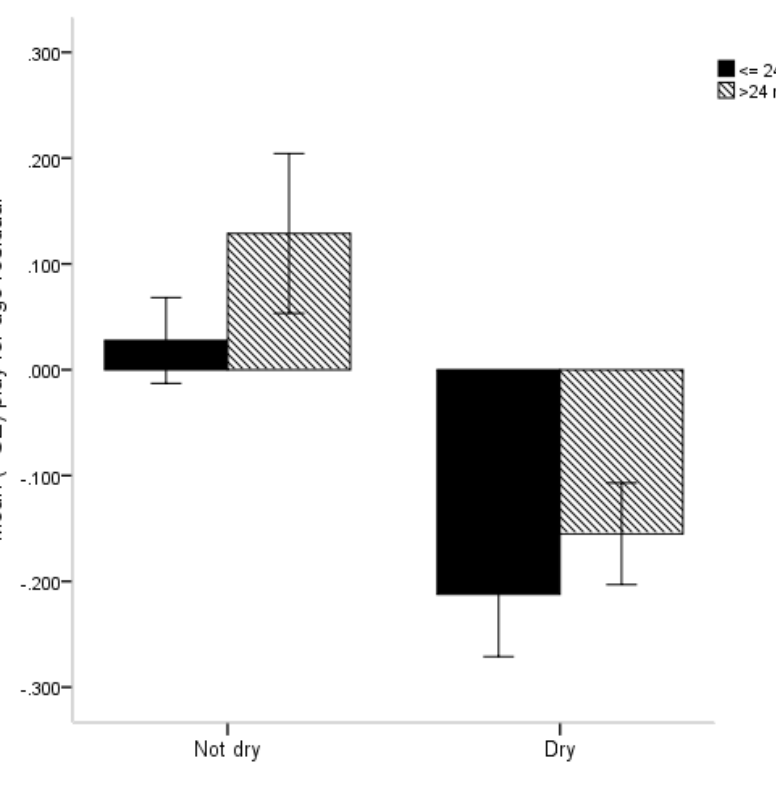
Figure 4. Age-corrected rates of play (residuals ± SE) compared between drought and non-drought periods and between younger and older calves.